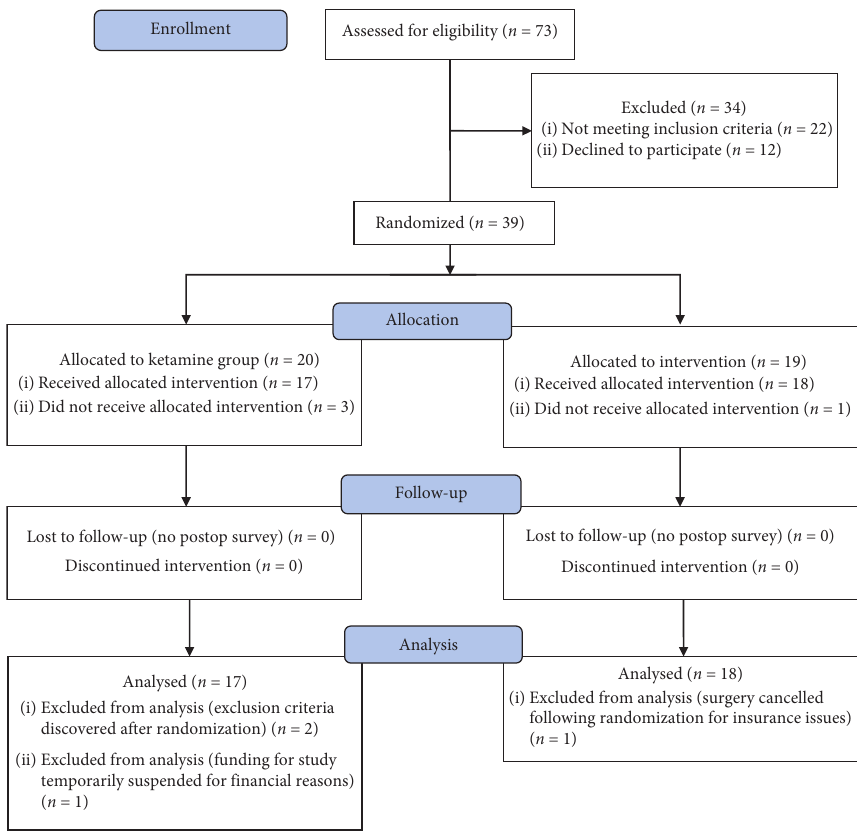
Figure 1: CONSORT flow diagram illustrating patient enrollment through analysis of the data. Table 1: Lists demographic data between the groups. Table 2: Medical comorbidity data between the two therapy